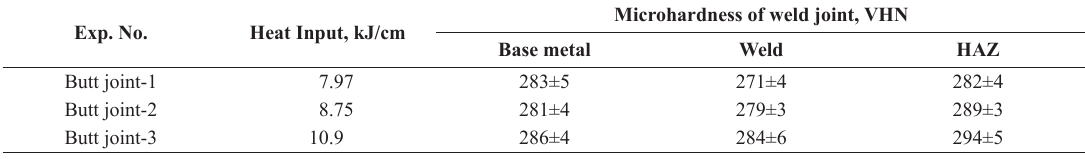
Table 4. Microhardness of base metal, weld and HAZ Exp. No.